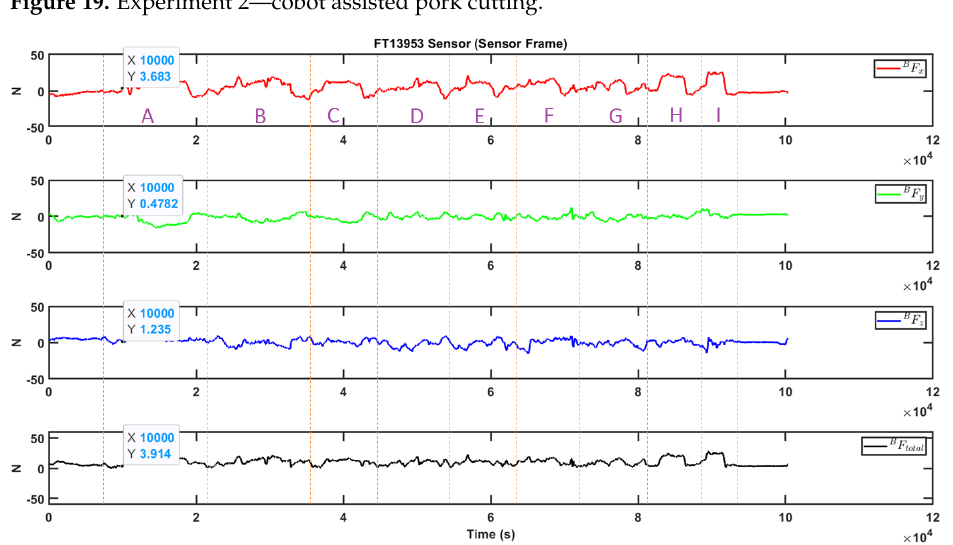
Figure 19. Experiment 2—cobot assisted pork cutting.